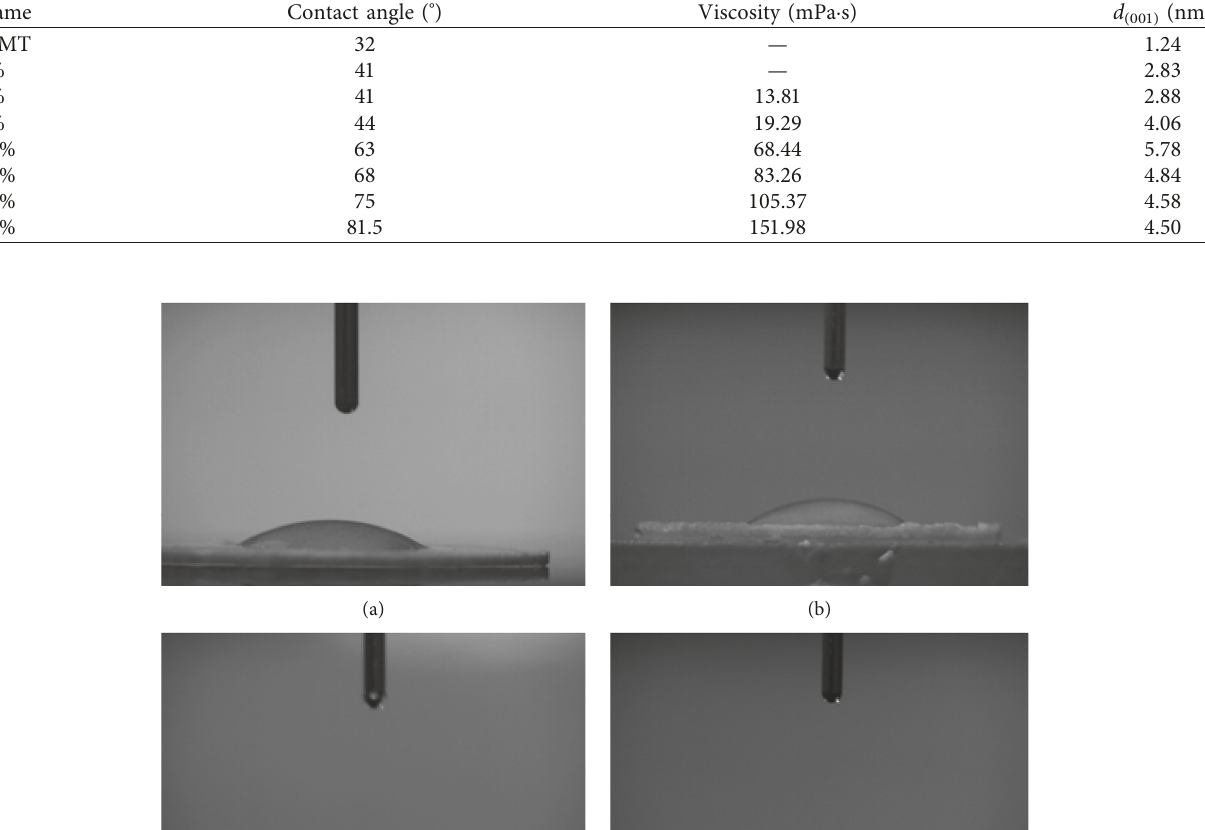
Table 1: Organic properties of MMT and C